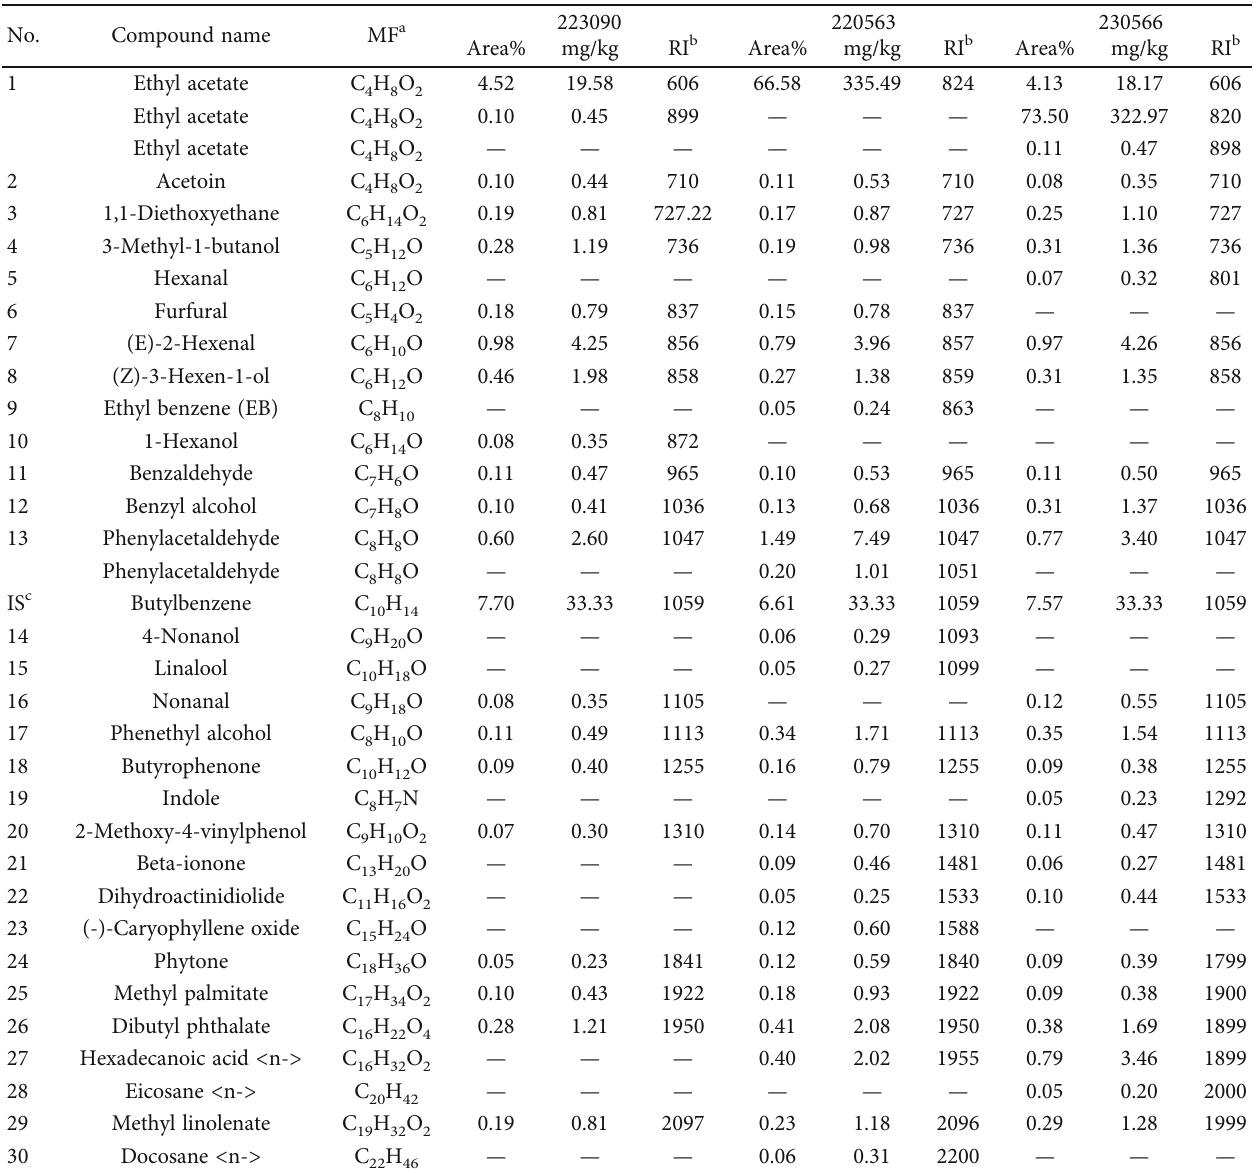
Table 2: Volatile organic compounds identi fi ed in anchote